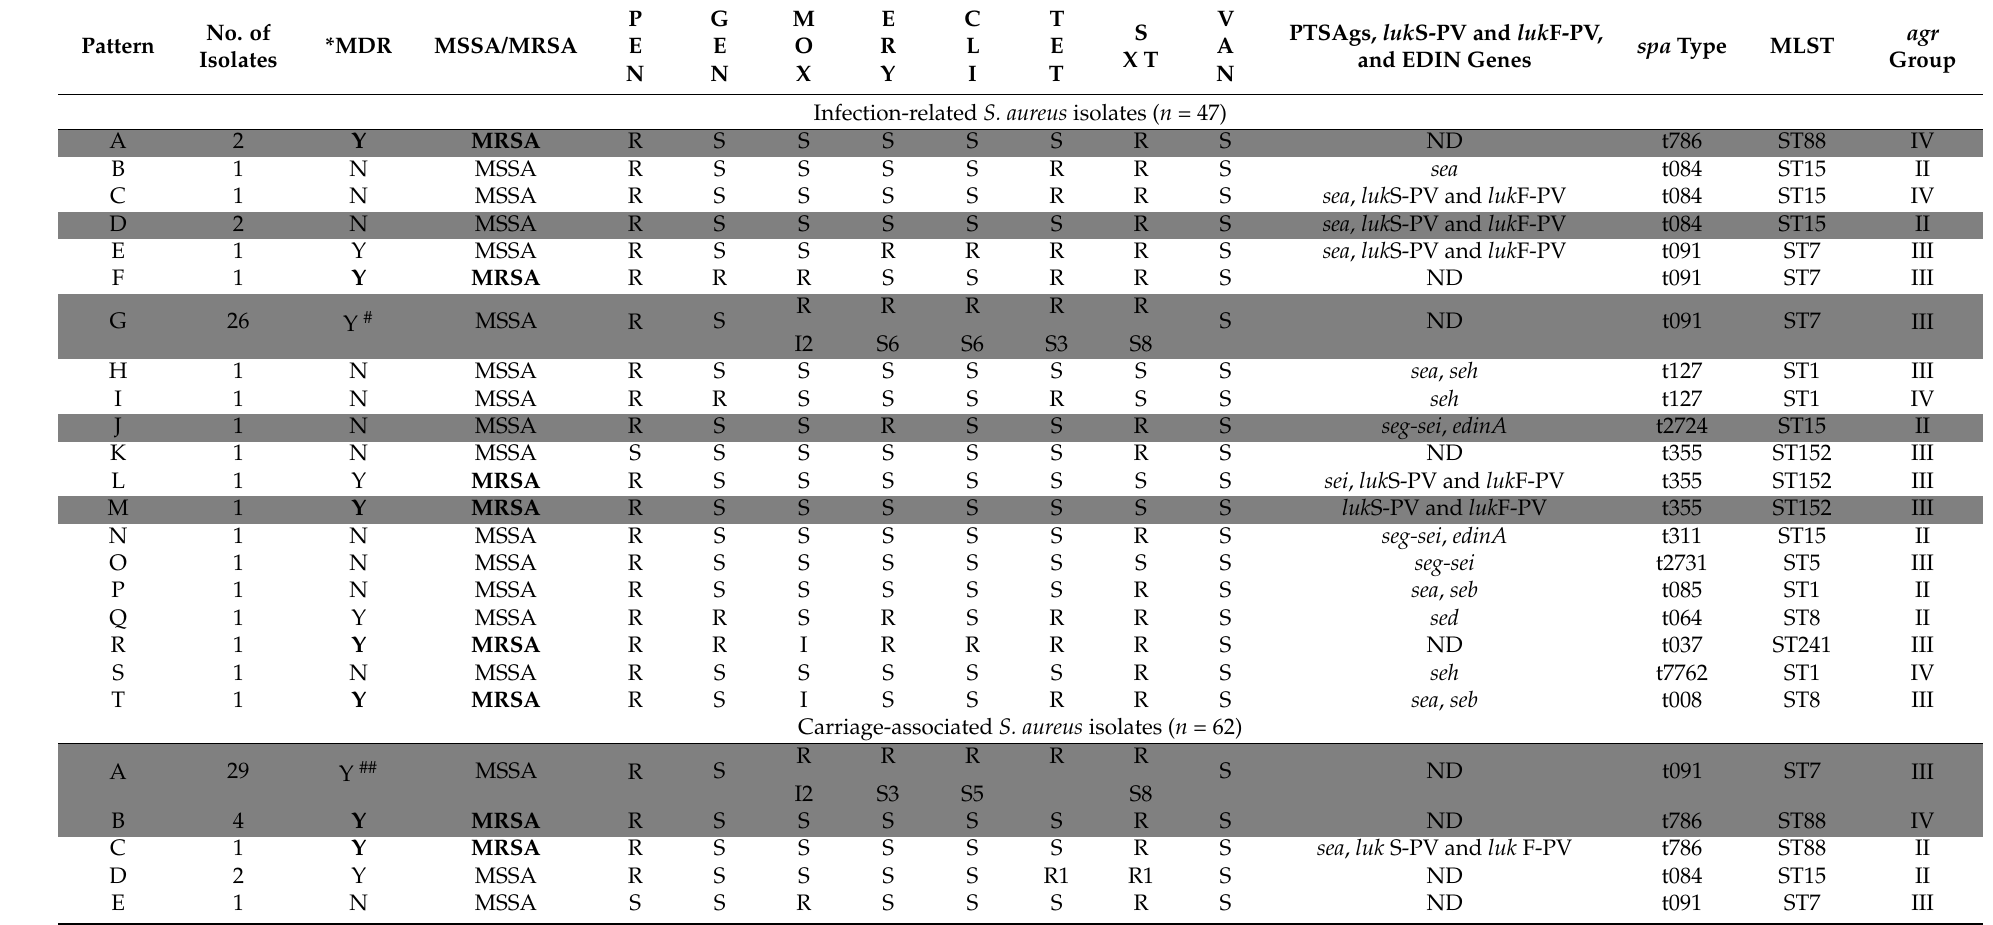
Table 2. Pattern analyses of all S. aureus isolates according to antibiotic resistance phenotype, toxin possession, and